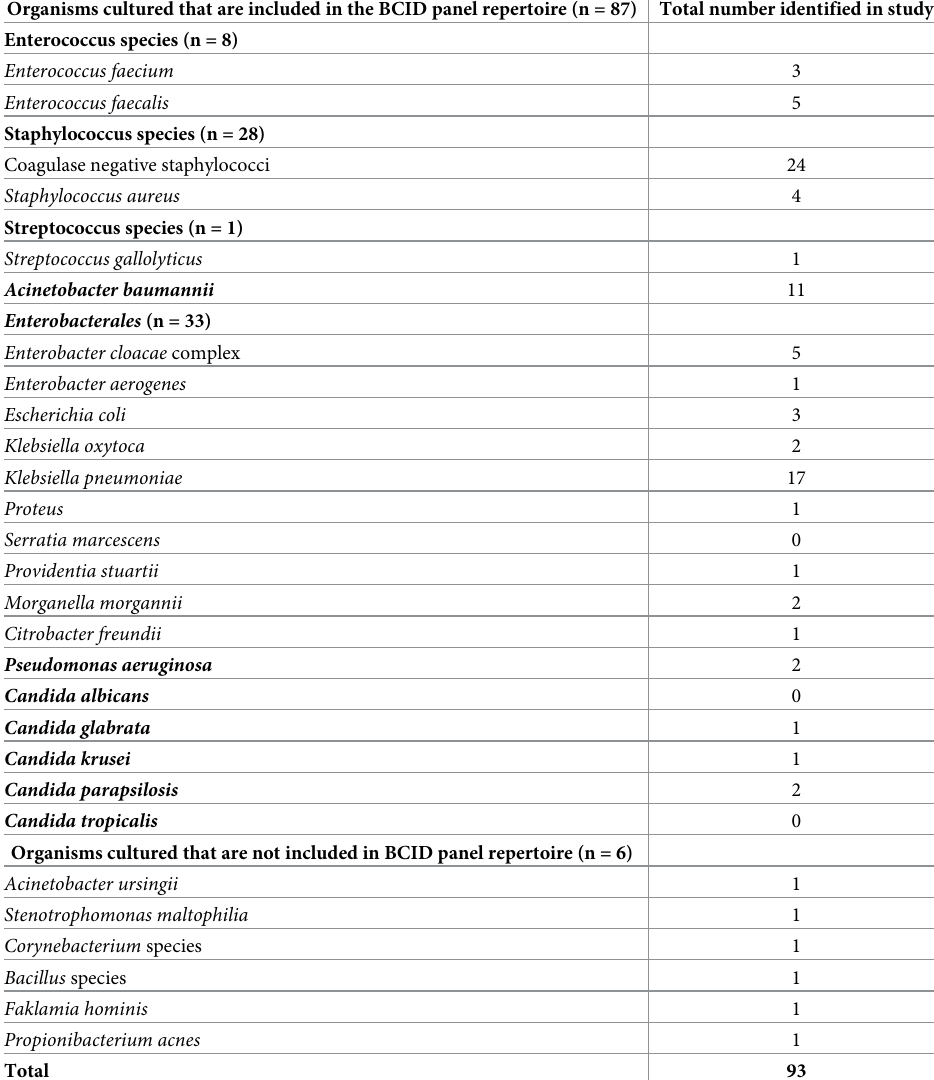
Table 1. Summary of organisms detected. Organisms cultured that are included in the BCID panel repertoire (n = 87) Total number identified in study